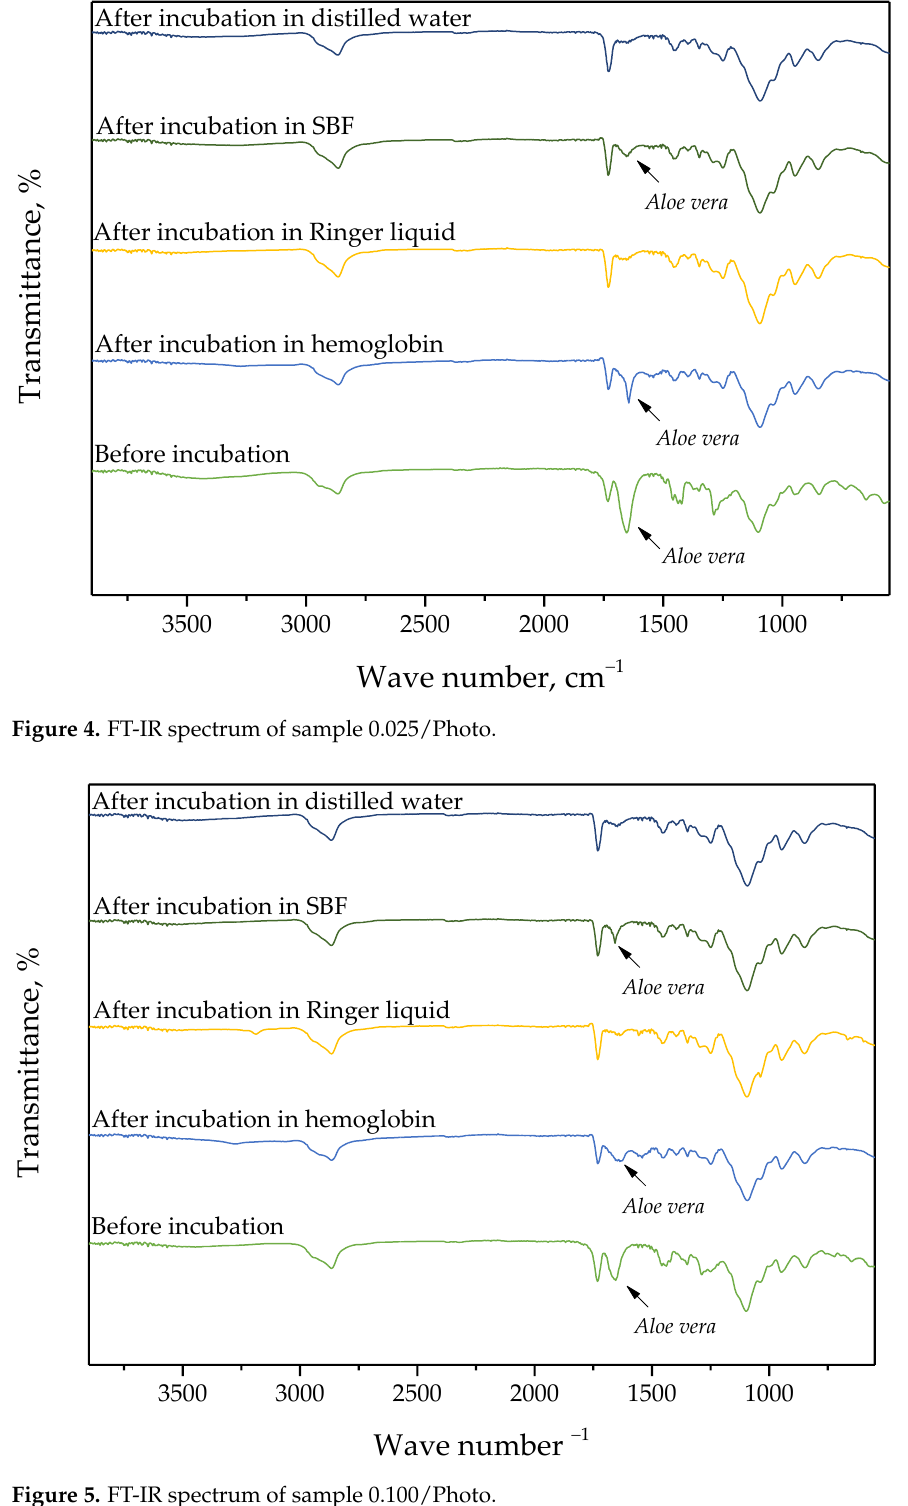
Figure 5. FT-IR spectrum of sample 0.100/Photo.